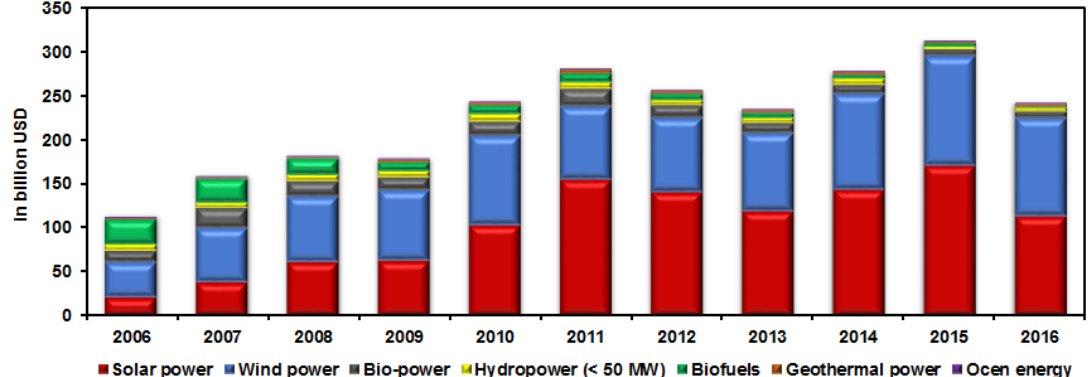
Energies 2018 , 11 , x 3 of 20